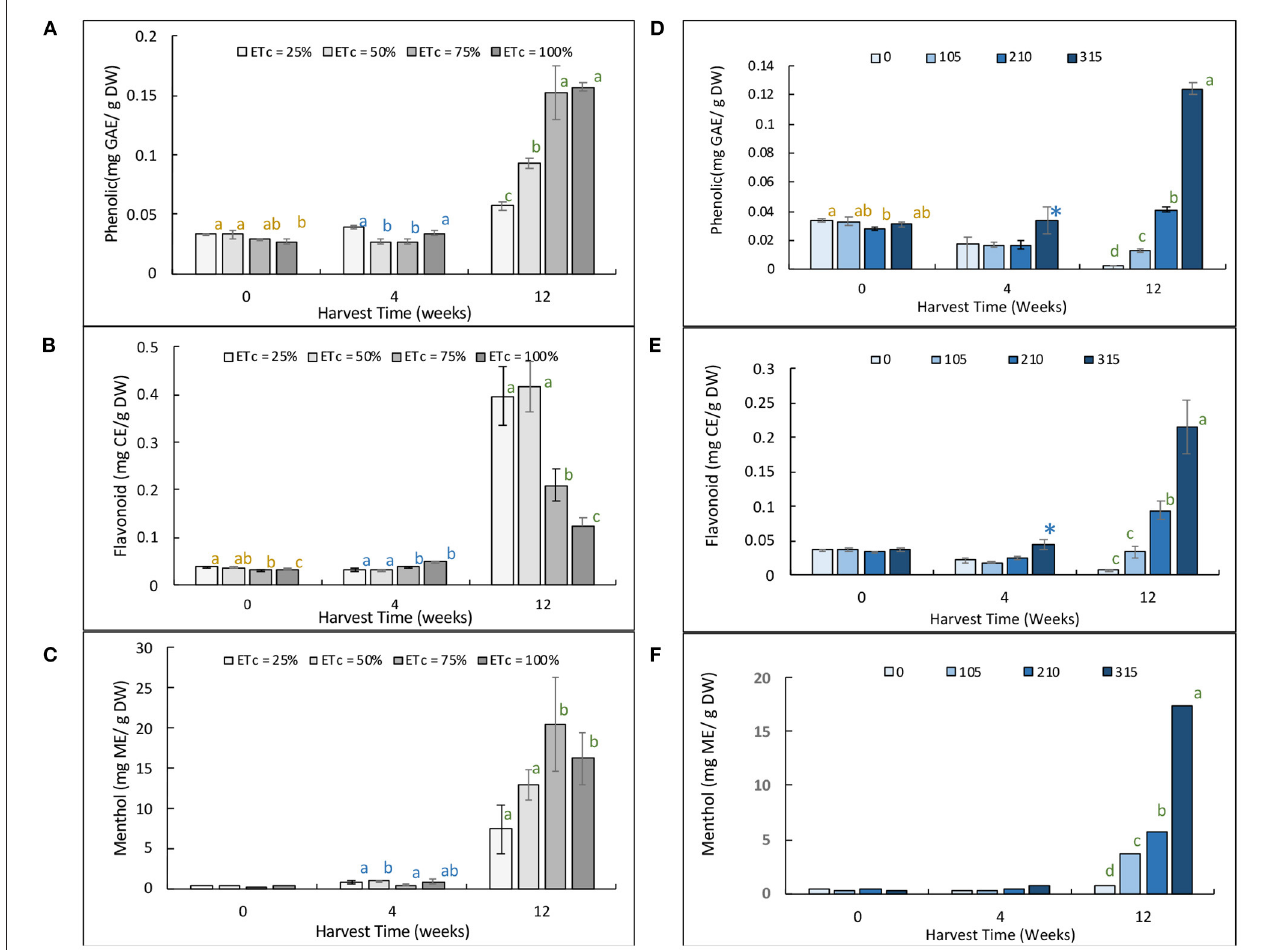
FIGURE 3 | Bioactive compound status as determined by total phenolic content (A,D) , total flavonoid content (B,E) , and menthol (C,F) of Japanese mints grown in the evaporative greenhouse system. The figures on the left are for Mentha arvensis grown in the evaporative greenhouse with different water regimes, and figures on the right are for Mentha arvensis grown in the evaporative greenhouse different level of nitrogen